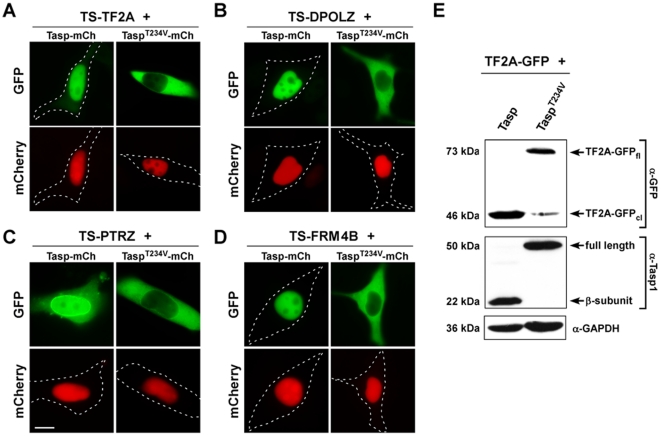
Analysis of Taspase1-mediated cleavage of in silico predicted targets.
A. HeLa cells were transfected with biosensors harboring full length TFIIA (TS-TF2A), the predicted cleavage site from DPOLZ (TS-DPOLZ), PTRZ (TS-PTRZ), or FRM4B (TS-FRM4B) together with the Tasp-mCh or inactive TaspT234V-mCh expression plasmid. 24 h later, trans-cleavage resulting in nuclear translocation of the biosensors was analyzed in at least 200 fluorescent living cells. Representative examples are shown. Productive cleavage was confirmed for all targets. Scale bars, 10 µm. B. Processing of full length TFIIA-GFP upon coexpression of Taspase1 but not of the inactive TaspT234V mutant shown by immunoblot analysis of transfected 293T cell lysates. Protein expression and cleavage was visualized by α-GFP and α-Taspase1 Ab. GAPDH served as loading control.